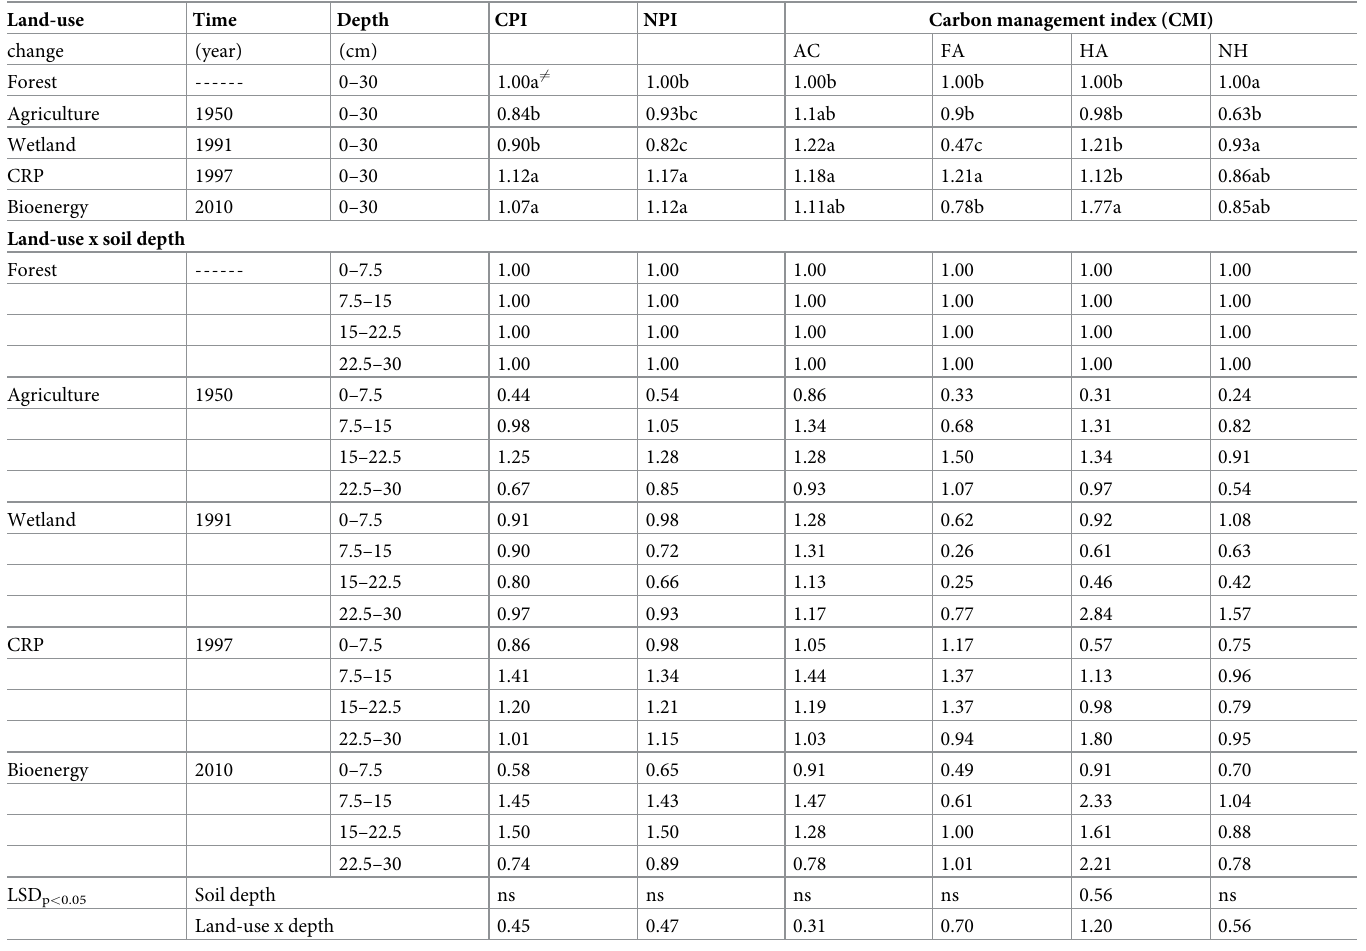
Table 6. Impact of deforestation and subsequent land-use diversity on the carbon and nitrogen pool (CPI and NPI) and management indices (CMI), calculated based on active carbon (AC), fulvic acid (FA), humic acid (HA), and glucose equivalent total non-humic carbon (NH) pools at different soil depths. Land-use